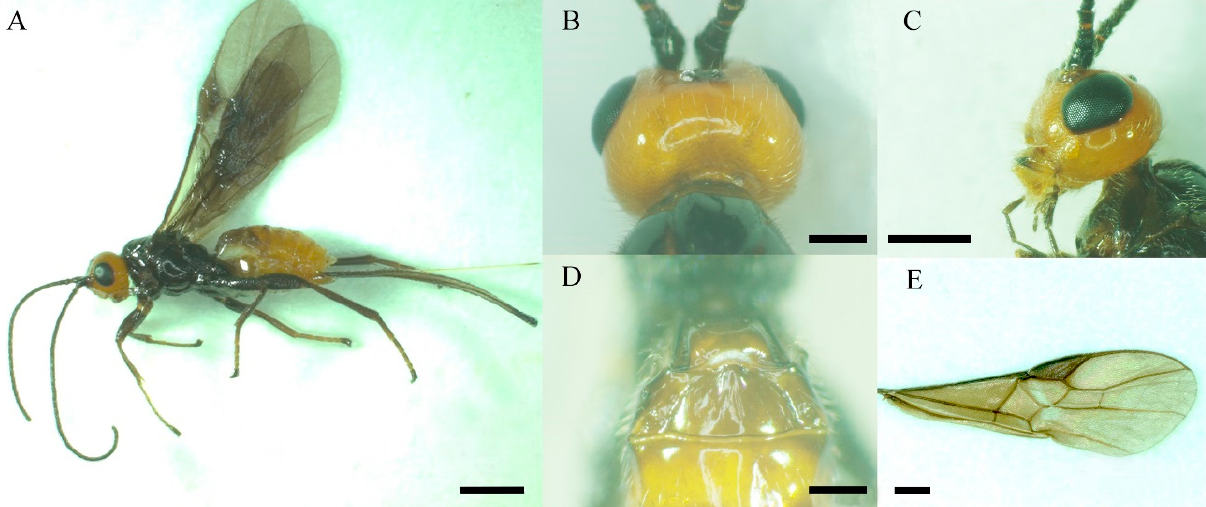
Figure 1. Diagnostic characteristics of adults of C. qinlingensis . ( A ) Habitus. ( B ) Head, dorsal view. ( C ) Head, lateral view. ( D ) Mesosoma, dorsal view. ( E ) Venation of right forewing. Scale bar: A = 1 mm μ m; B and D = 0.2 mm; C and E = 0.5 mm.